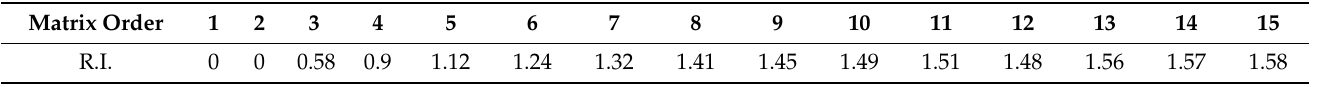
Table 2. The values of the random consistency index.